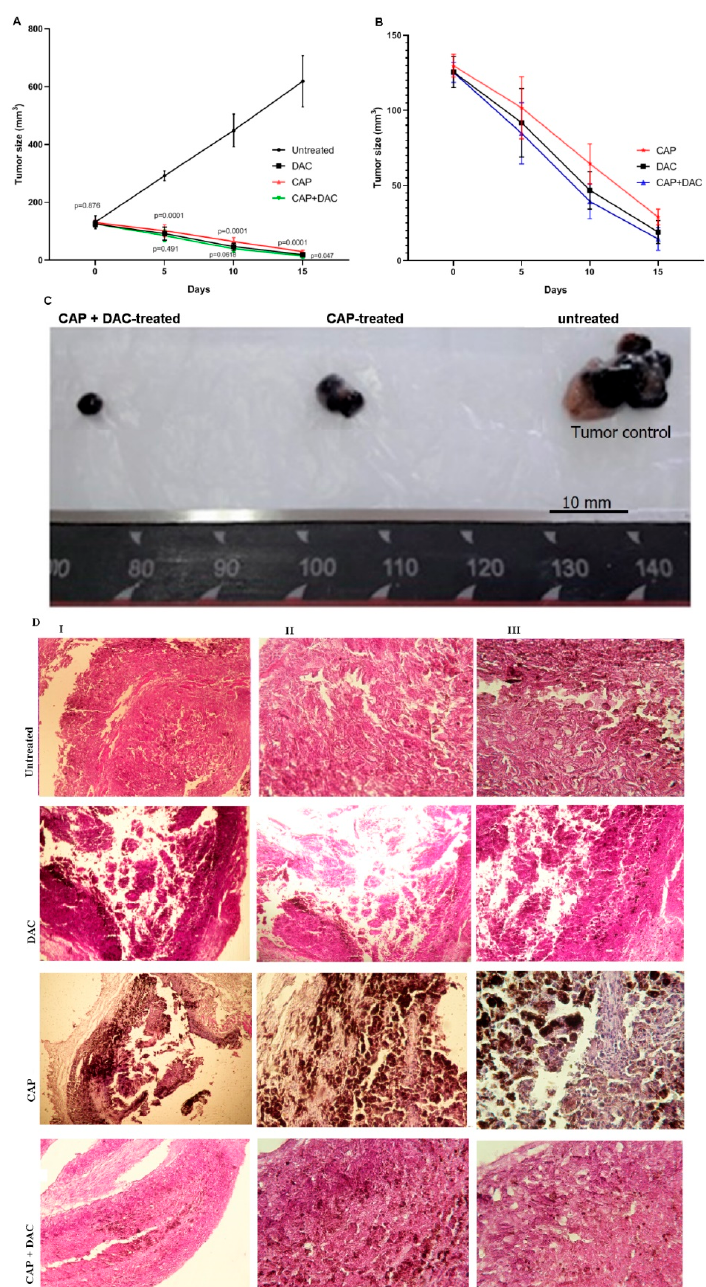
Figure 6. Effect of CAP and DAC mono and combination therapy on melanoma progression in vivo. B16 tumor-bearing mice either left untreated or treated with CAP, DAC, or CAP+DAC combination therapy. Tumor size was evaluated every five days with the statistical comparison of tumor size in the CAP-treated group to the untreated group (upper p -values) and between DAC and combination therapy (lower p -values). ( A ) Comparison of tumor volume of all groups at a lower scale. ( B ) Representative images of tumors treated with CAP, combination therapy, and of the untreated group ( C ) after two treatments. H&E staining on the tenth day after inoculation of the tumor ( D ) of a nodular tumor that occupied the dermis (I), area of necrosis (II), and pleomorphic and achromic epithelioid malignant melanocytes with vesiculous nuclei and eosinophilic macronuclei (III). Data are presented as mean ± SD of at least five mice for each time